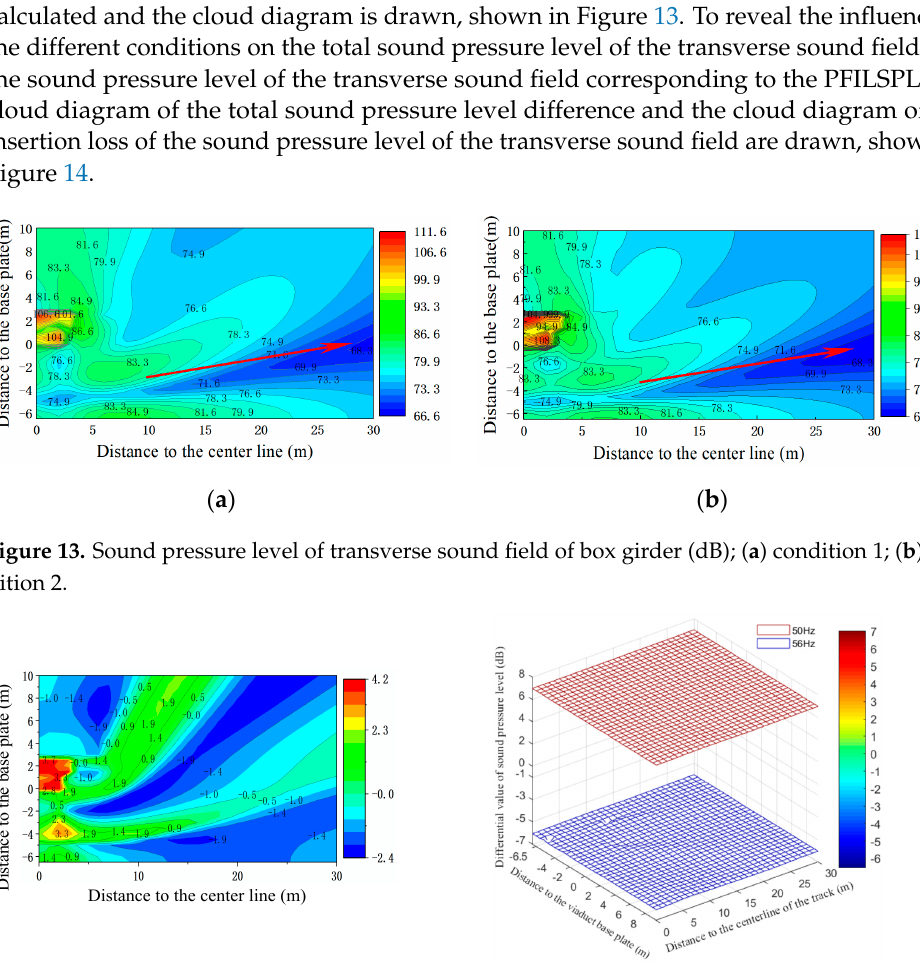
S S − ); ( b ) the insertion 2 1 i i